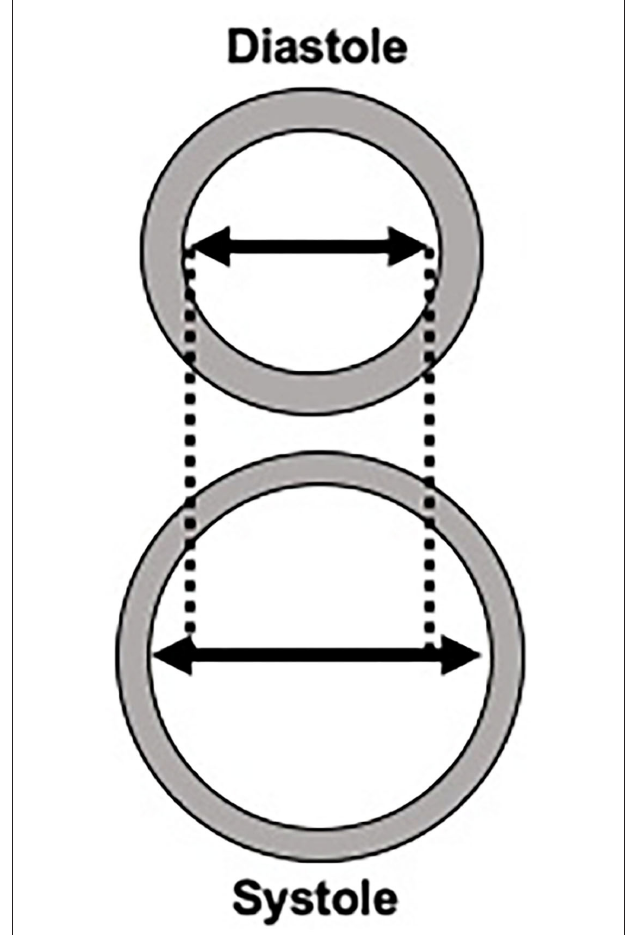
FIGURE 2 | Potential mechanisms for the role of arterial stiffness in the development of stroke and